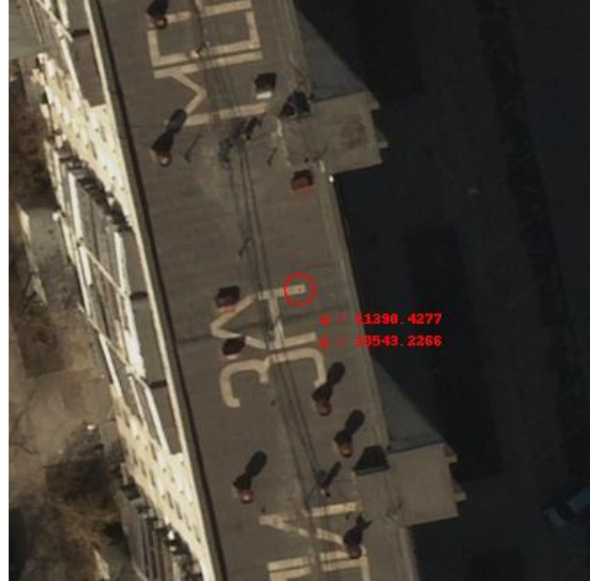
Figure 9 . An example of an image frame with a tie point on the roof of a building generated by the software.